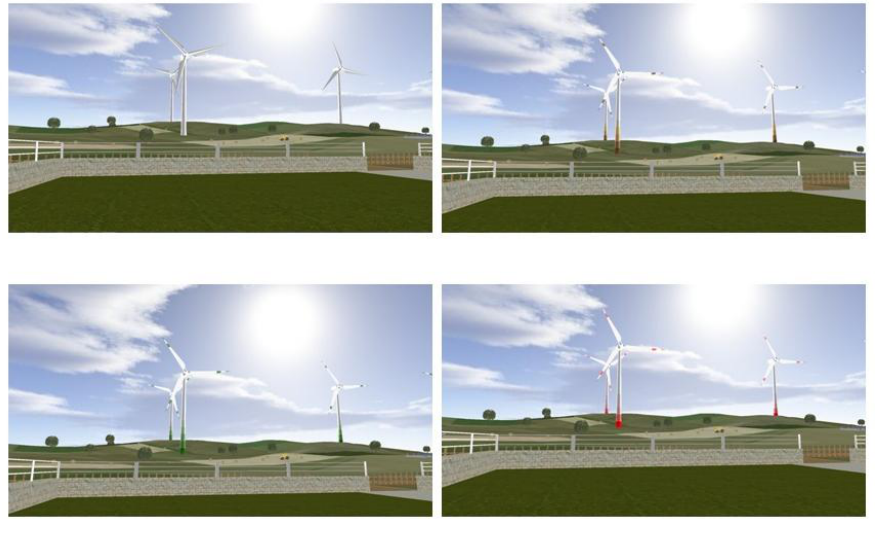
Figure 3. Frames of the scenarios with six turbines at 250 m: white, brown, green and